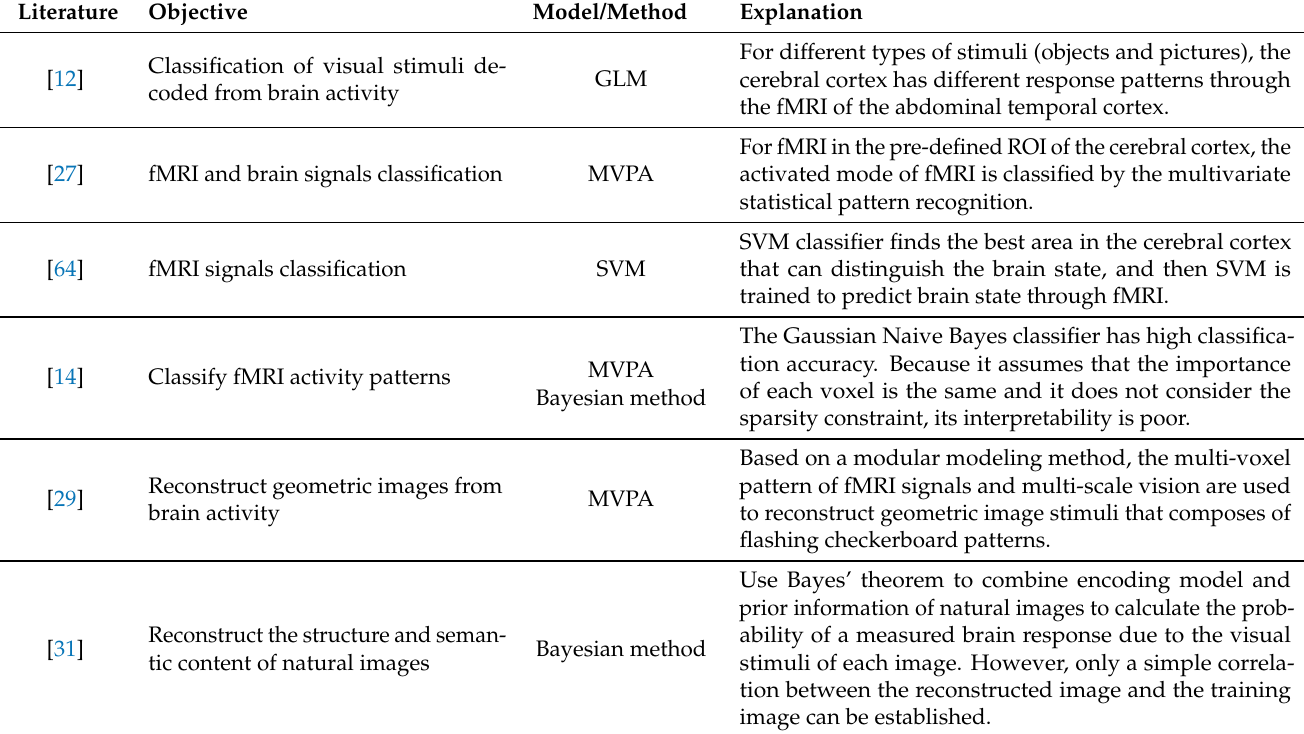
Table 2. Brain decoding model based on machine